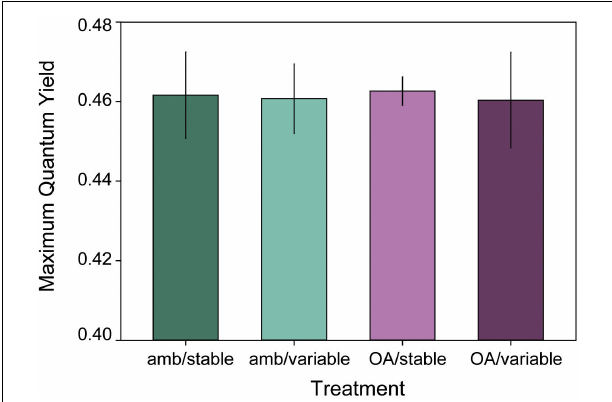
FIGURE 4 | Mean ( ± SE) maximum quantum yield of L. congestum after 16 weeks of exposure to treatment conditions ( n = 6). There were no significant effects of treatment on maximum quantum